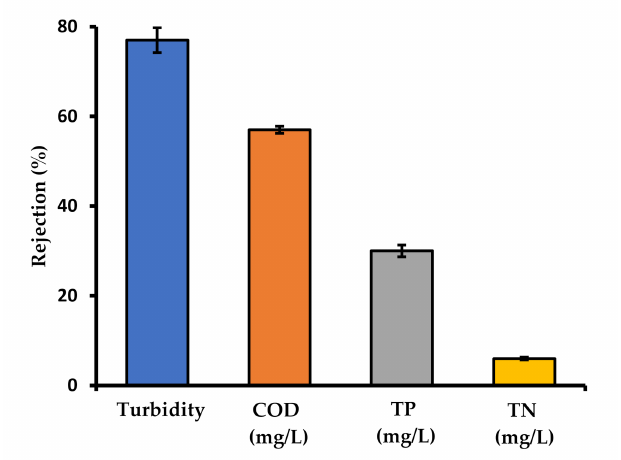
Figure 4. Rejection performance.